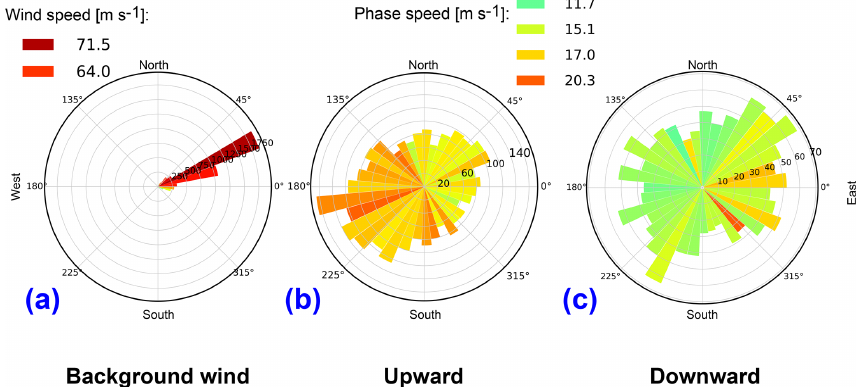
Figure 15. Polar histograms of the direction of the background wind (a) and waves for upward-propagating (b) and downward-propagating (c) waves. Length of the bars represents the number of waves per 10 ◦ horizontal direction. The color represents the average wind (a) or average intrinsic phase speeds (b, c) or the respective